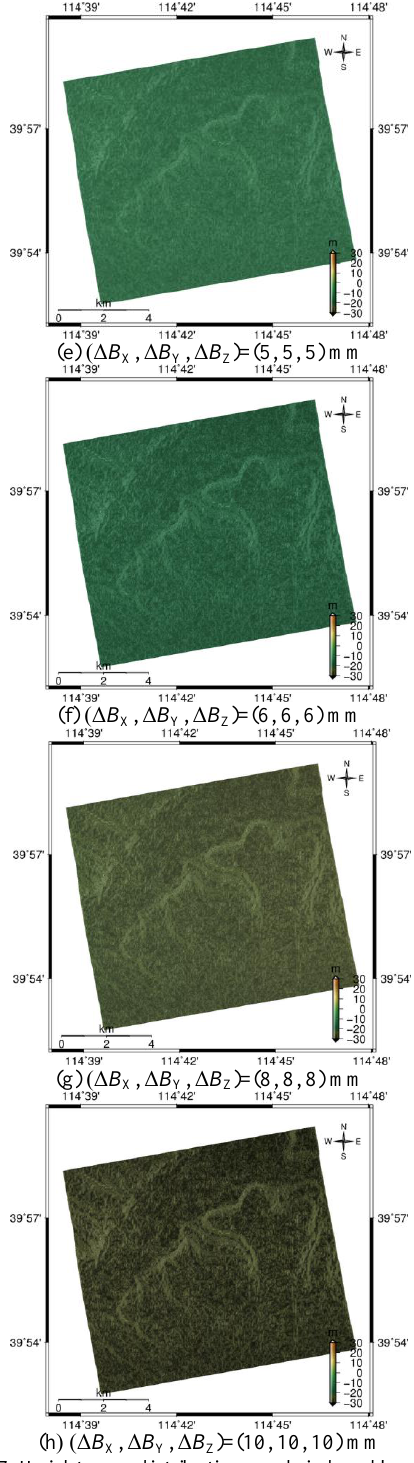
Figure 7. Height error distribution graph induced by different baseline error The simulation results indicate that the baseline error has significant influence on InSAR height measurement. With the increase of baseline error, the height measurement error increased gradually, which show good agreement with the theoretical analysis. The spatial error distribution graph directly represented the pixel-to-pixel influence of baseline error to height